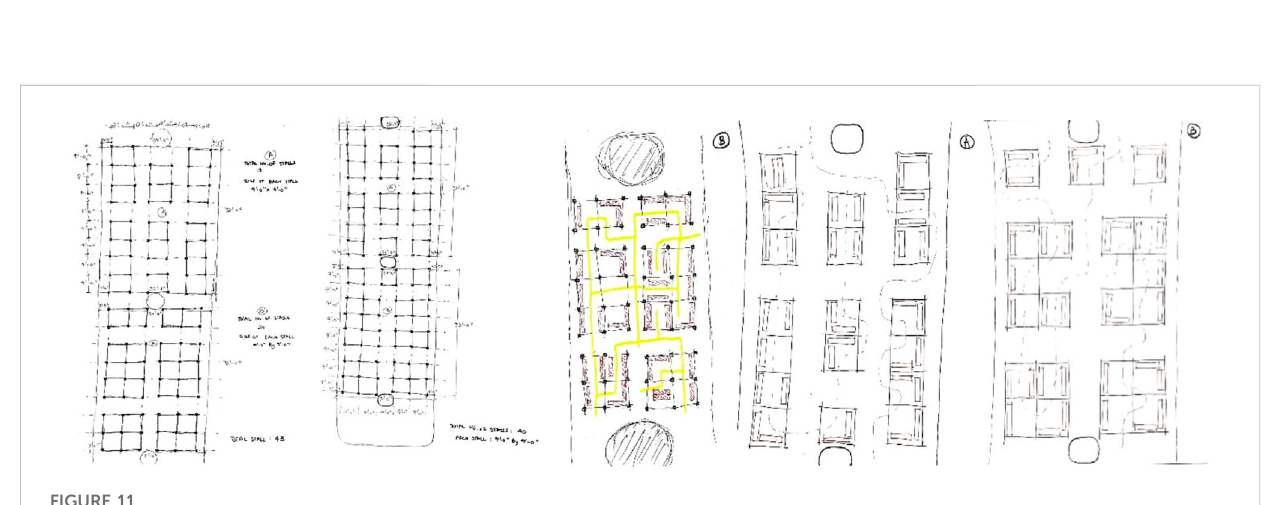
Arrangement of the column and circulation